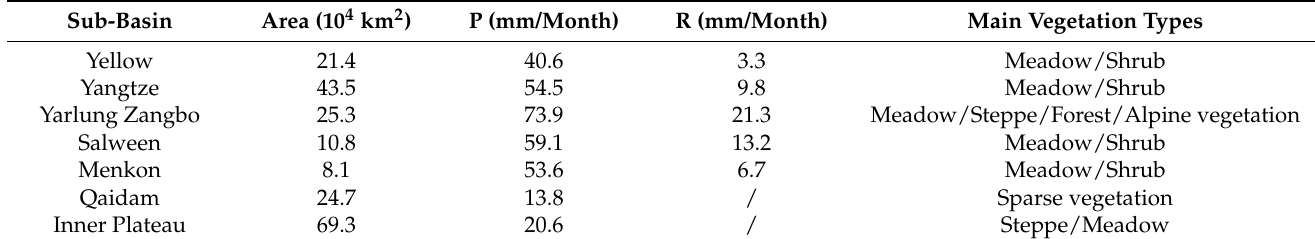
Figure 1. The sub ‐ basin distribution map of the Tibetan Plateau.